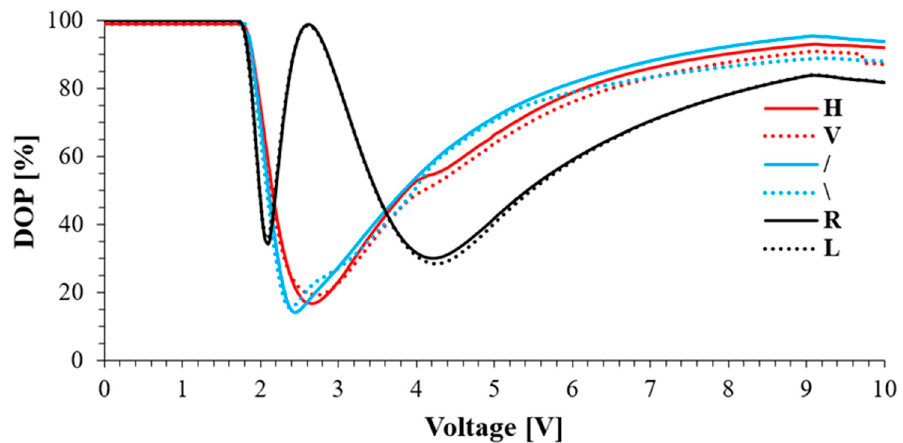
Figure 2. Measurement results of the DOP for VAN as a function of applied voltage for different input SOP; Linear horizontal (H) and vertical (V), linear at an angle of +45°(/) and − 45°(\), circular right (R) and left (L).